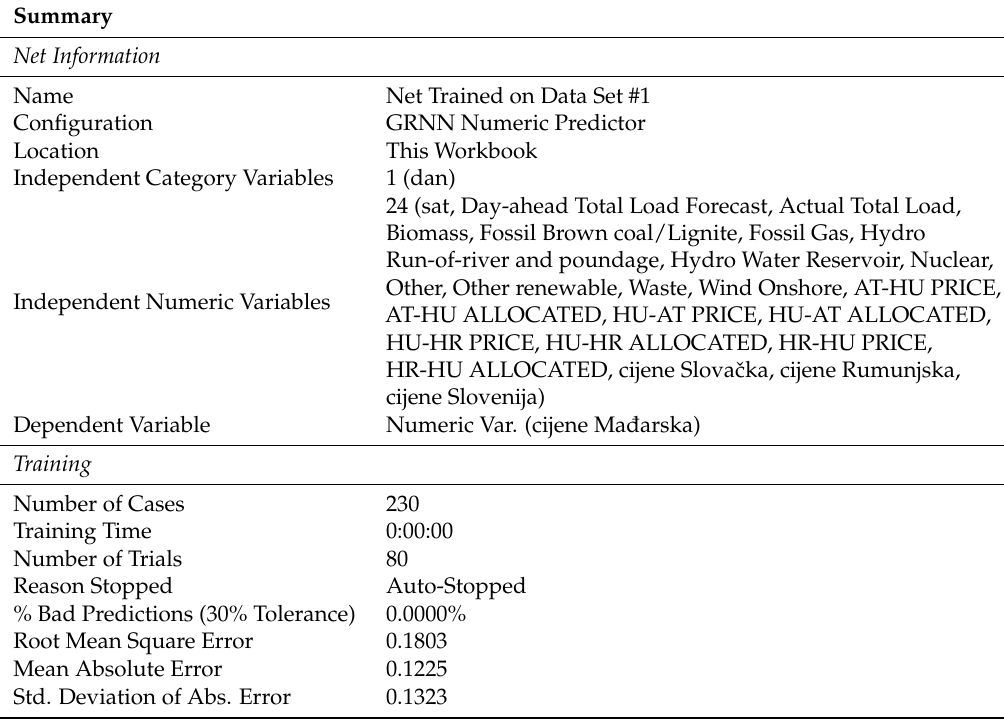
Table A3. Sensitivity analysis results for input parameters in the third